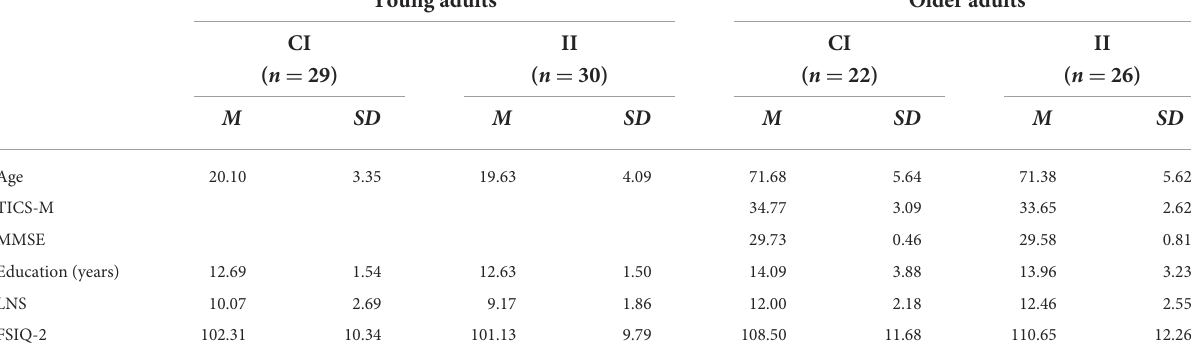
TABLE 1 Demographic characteristics and cognitive measures by age group and